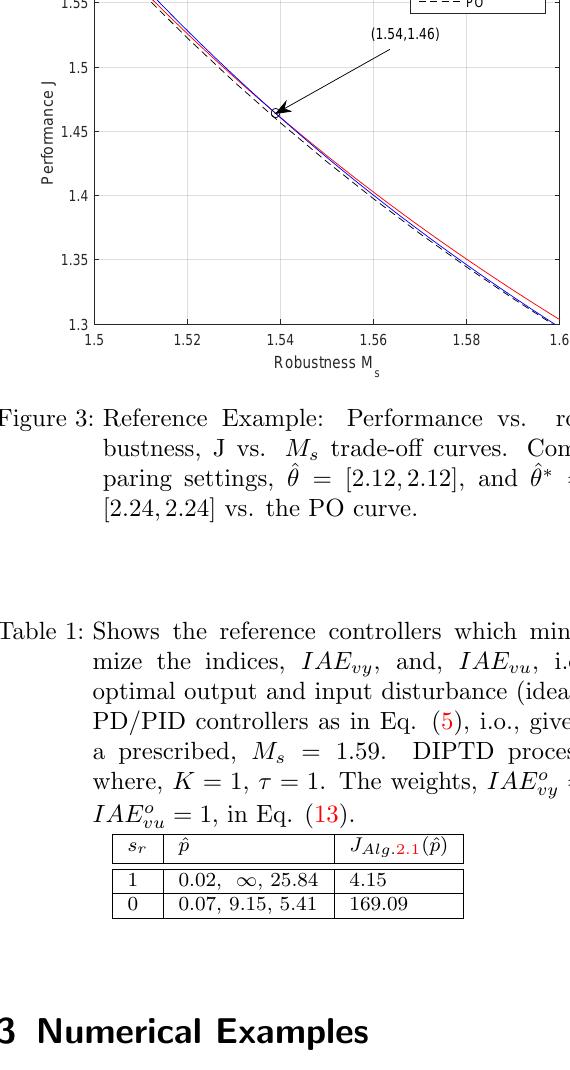
Table 1: Shows the reference controllers which mini- mize the indices, IAE vy , and, IAE vu , i.e. optimal output and input disturbance (ideal) PD/PID controllers as in Eq. (5), i.o., given a prescribed, M s = 1 . 59. DIPTD